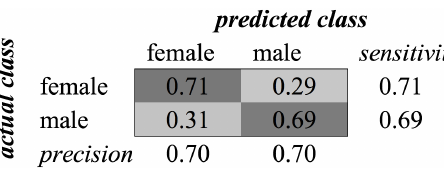
Figure A7. SVM confusion matrix of category Gender (without child class) for MFCC feature type.